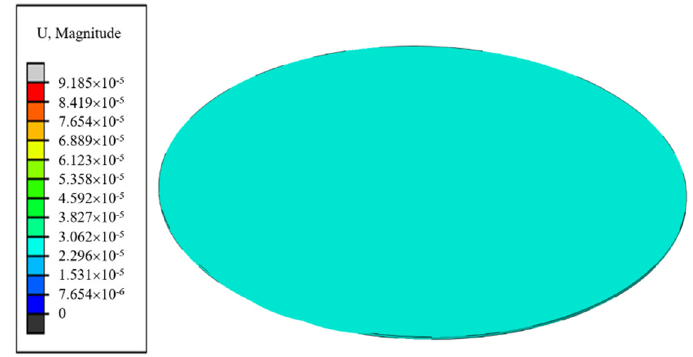
Figure 6. Axial displacement nephogram of the pressboard (TEM11) at the moment of 1.03.